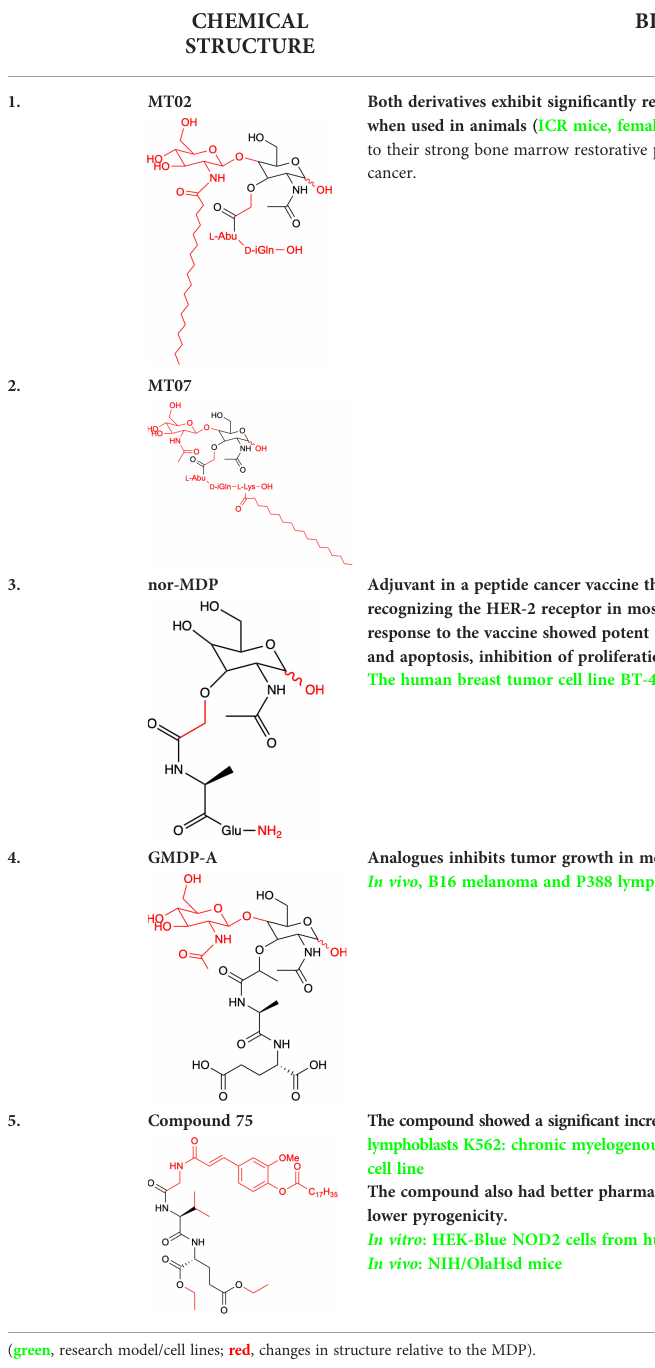
TABLE 1 MDP analogues for potential adjuvant use in anticancer